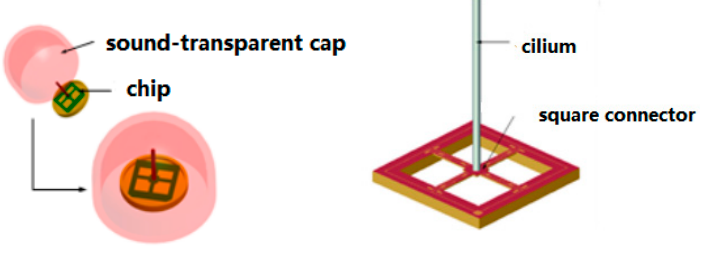
Figure 1. Microstructure model.